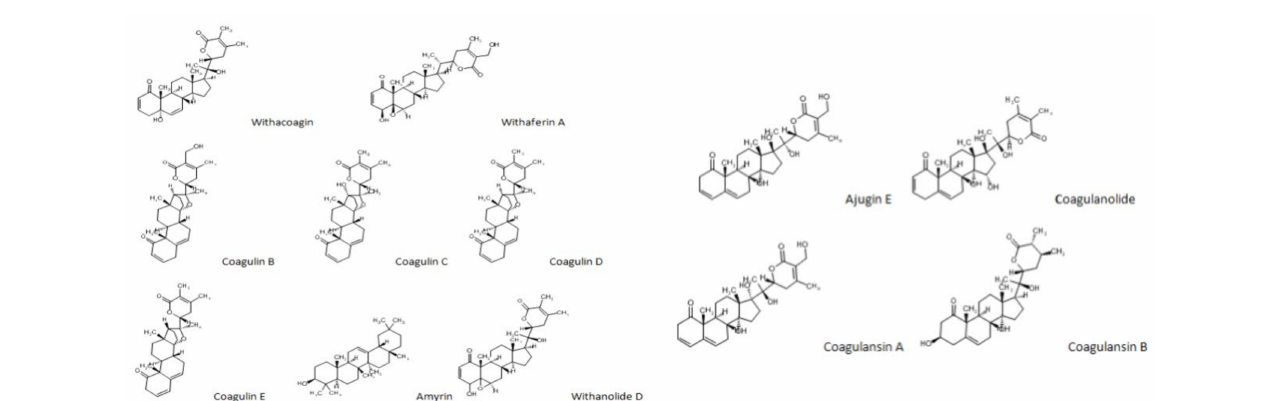
Figure 2. Structure of Withanolides of W. Coagulans